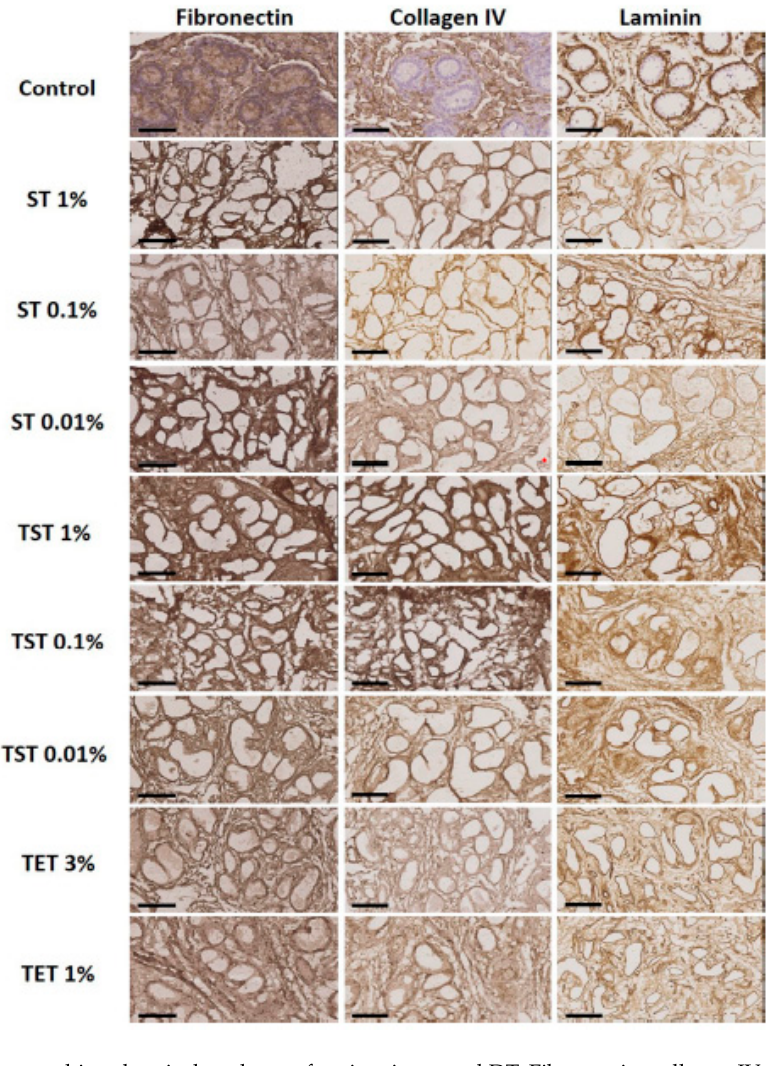
Figure 4. Immunohistochemical analyses of native tissue and DT. Fibronectin, collagen IV and laminin were preserved in tissue decellularized with all protocols in all conditions. Scale bar = 70 µm.